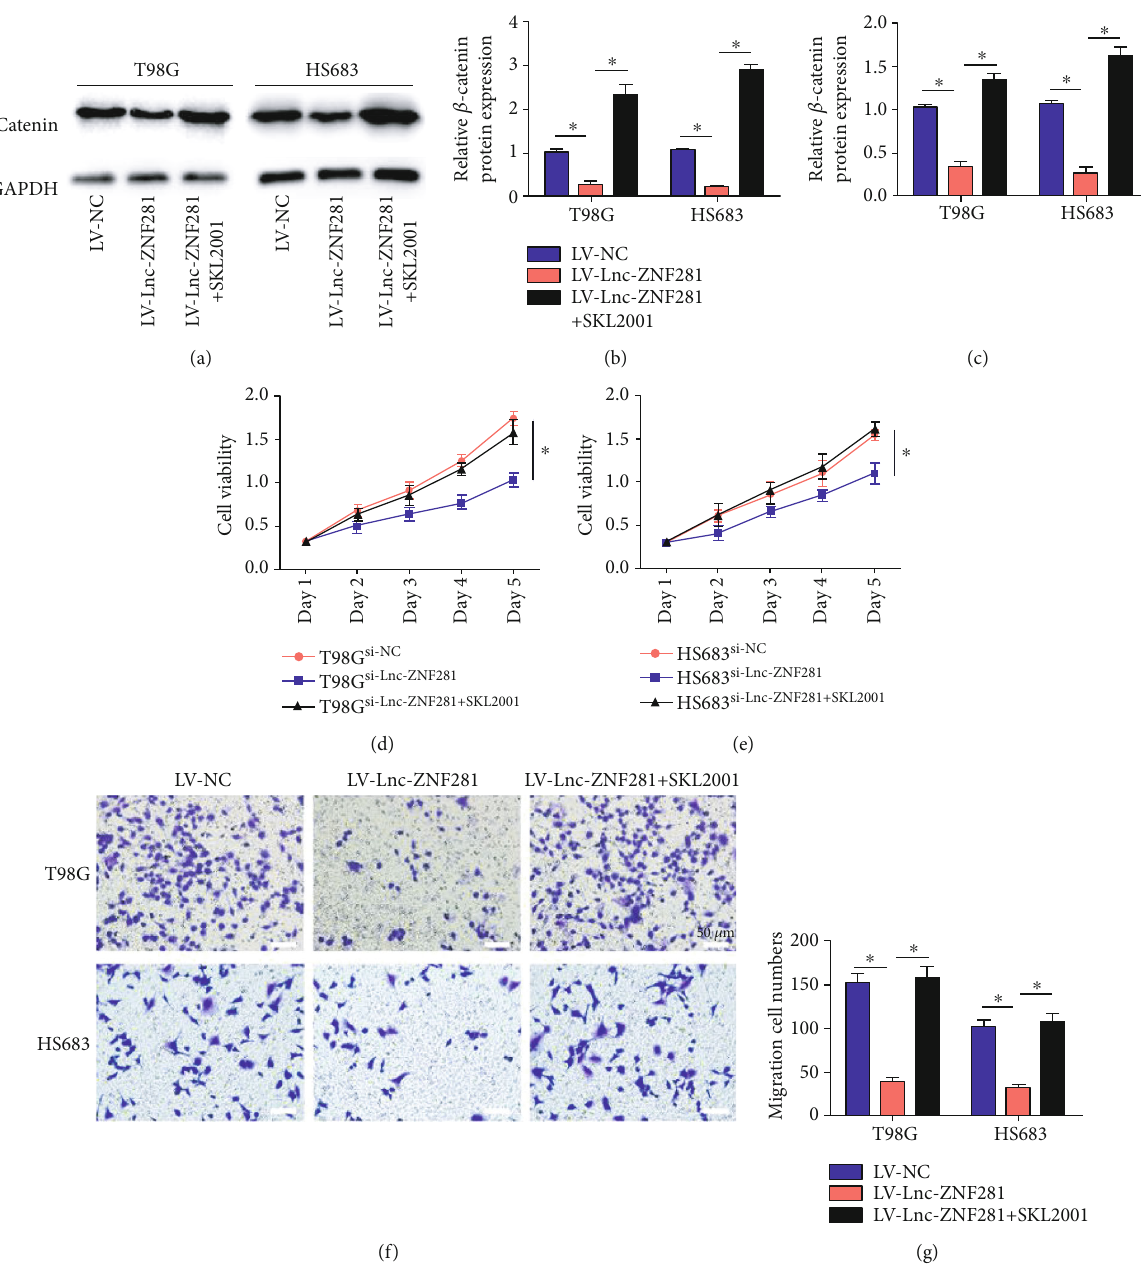
Figure 6: Increased β -catenin reversed the suppressive e ff ects of lnc-ZNF281 on glioma cells. (a – c) β -catenin agonist SKL2001 was used to upregulate β -catenin expression, and the Western blot results showed that SKL2001 signi fi cantly increased the protein expression levels of β - catenin. (d, e) The CCK-8 assay results indicated that β -catenin reversed the inhibitory e ff ects of lnc-ZNF281 on the proliferation of glioma cells. (f, g) The transwell assay results indicated that β -catenin reversed the inhibitory e ff ects of lnc-ZNF281 on the migration of glioma cells. Scale bars = 50 μ m. ∗ p < 0 : 05